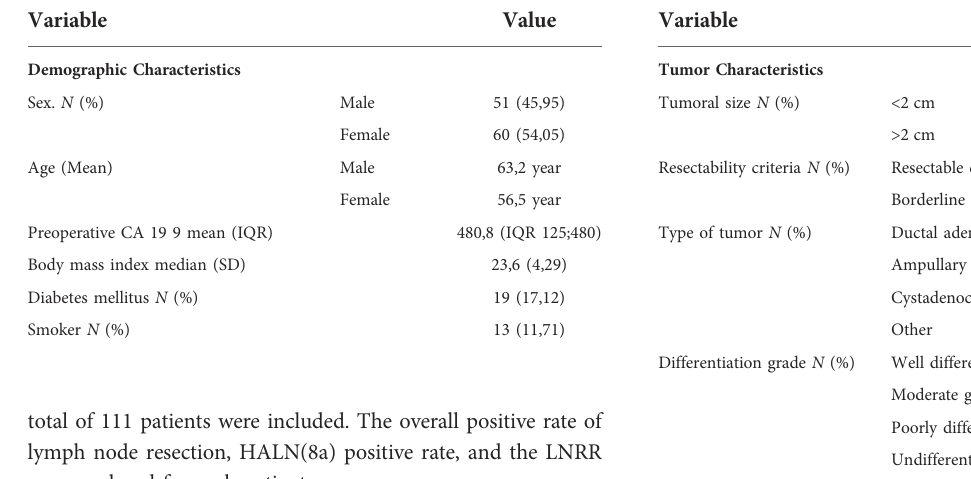
TABLE 1 Patient demographics. TABLE 2 Pathologic